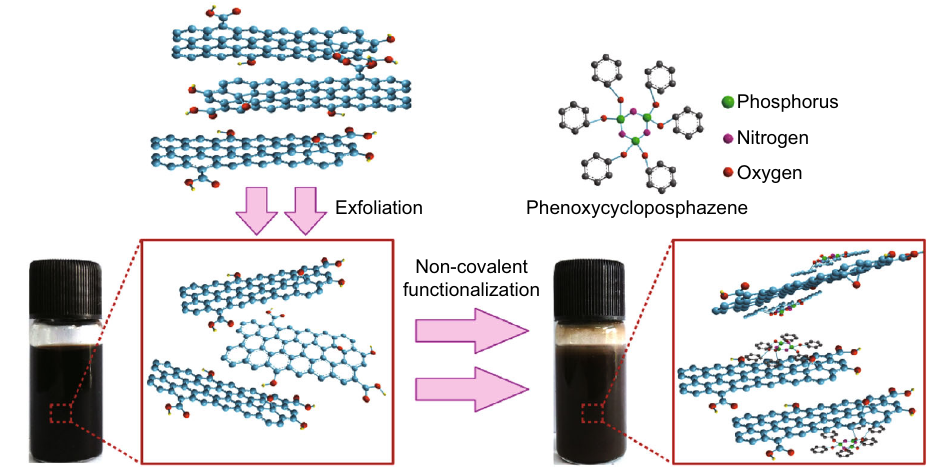
Fig. 1 Schematic diagram showing overall processing of non-covalently FGO